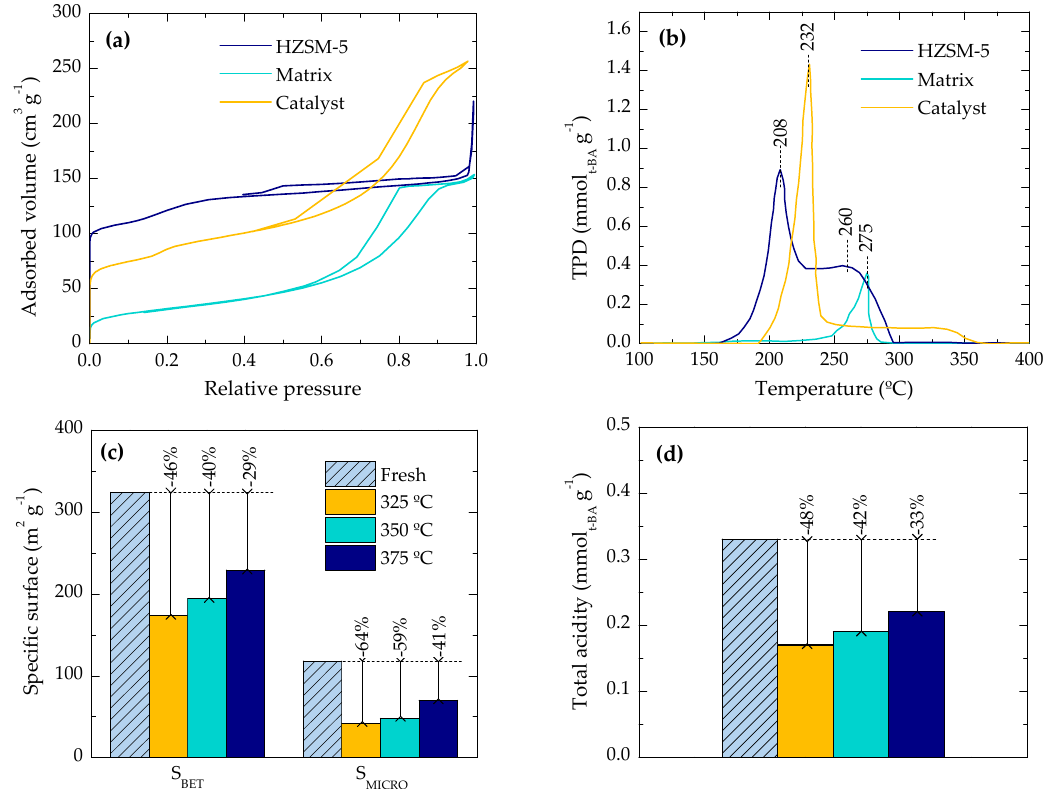
Figure 2. ( a ) N 2 adsorption-desorption isotherms and ( b ) t-BA desorption profiles of the HZSM-5 zeolite, the γ -Al 2 O 3 matrix and the final catalyst. Effect of reaction temperature on the deterioration of ( c ) the specific BET surface area and the micropore surface area, and ( d ) the total acidity of deactivated catalysts (annotations refer to the decrease in each value).